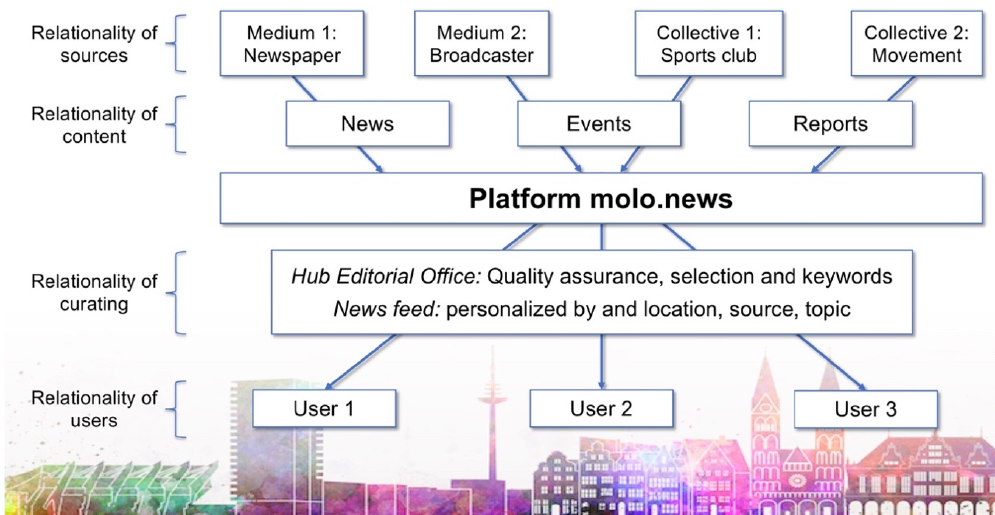
Figure 2. Molo-news as a relational